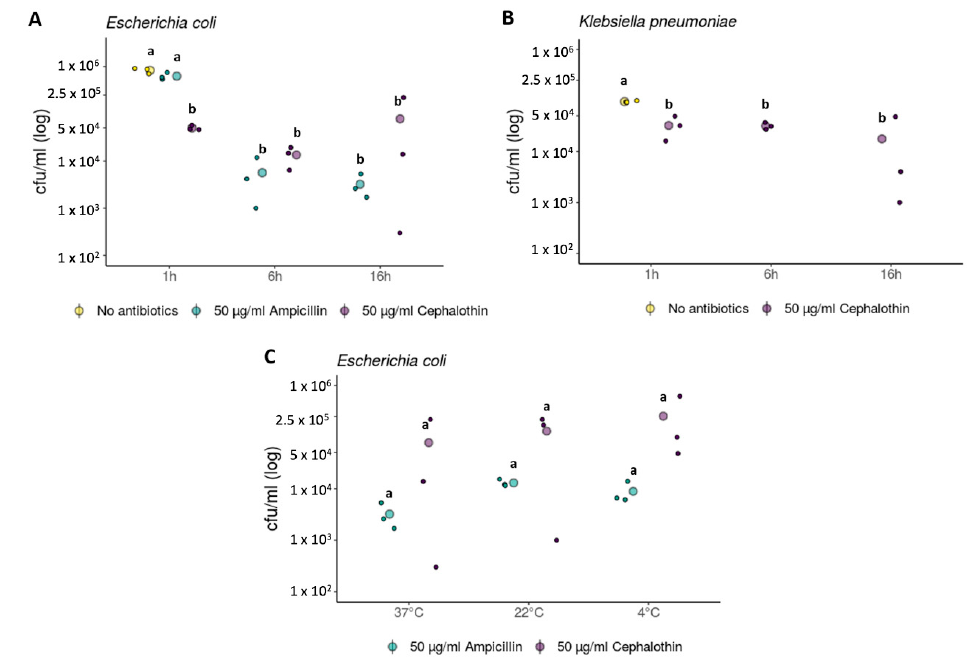
Figure 3. Evolutionary rescue of Escherichia coli and Klebsiella pneumoniae after differing exposure times and at different temperatures. The big dots represent the evolutionary rescue presented as the mean cell density in colony forming units (cfu)/mL of formed transconjugants after the exposure to either ampicillin (50 µg/mL) or cephalothin (50 µg/mL) and the introduction of a rescuing strain harboring beta-lactamase resistance gene against these antibiotics in conjugative plasmid pEC13. The small dots represent individual data points per treatment. For reference, the number of transconjugants in the absence of antibiotics was measured at the 1 h time point. Statistical analysis and standard deviations are presented in Table S1. Letters indicate the results from Tukey’s “Honest Significant Difference” test. Groups indicated by the same letter do not differ significantly. Different exposure times to antibiotics were tested for ( A ) Escherichia coli and ( B ) Klebsiella pneumoniae. ( C ) The effect of temperature (37, 22 or 4 °C) on the evolutionary rescue of E. coli was measured after 16 h exposure to ampicillin and cephalothin. The prevailing temperature has a substantial effect on the rate at which bacteria replicate. Given that replication itself is dependent on the generation of new cell walls, it is possible that lower temperatures hinder the efficacy of cell-wall-targeting antibiotics and thus allow more bacteria to acquire the plasmid. As such, we tested whether temperature has an effect to bacterial survival via evolutionary rescue in the presence of antibiotics. E. coli was exposed to cephalothin and ampicillin at 4°C, room temperature (22 °C), and 37 °C for 16 h before the introduction of the pEC13-harboring strain (Figure 3C; Table S4). We found no significant difference in the rescued cells between cephalothin and ampicillin ( p = 0.055; Table S5), nor the temperatures used ( p = 0.56; Table S5). Nevertheless, this suggests that the persisting cells are already present in the population before the exposure to antibiotics. As such, the migration of bacteria harboring conjugative resistance plasmids